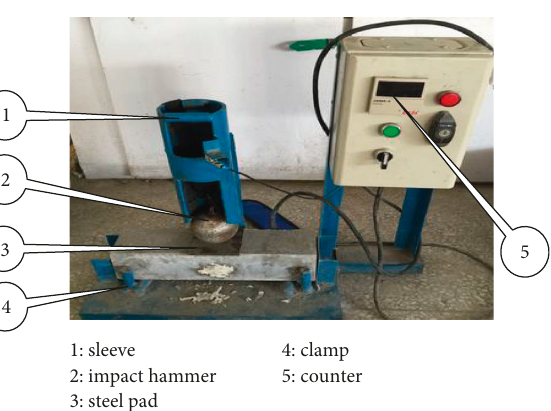
Figure 1: Impact test